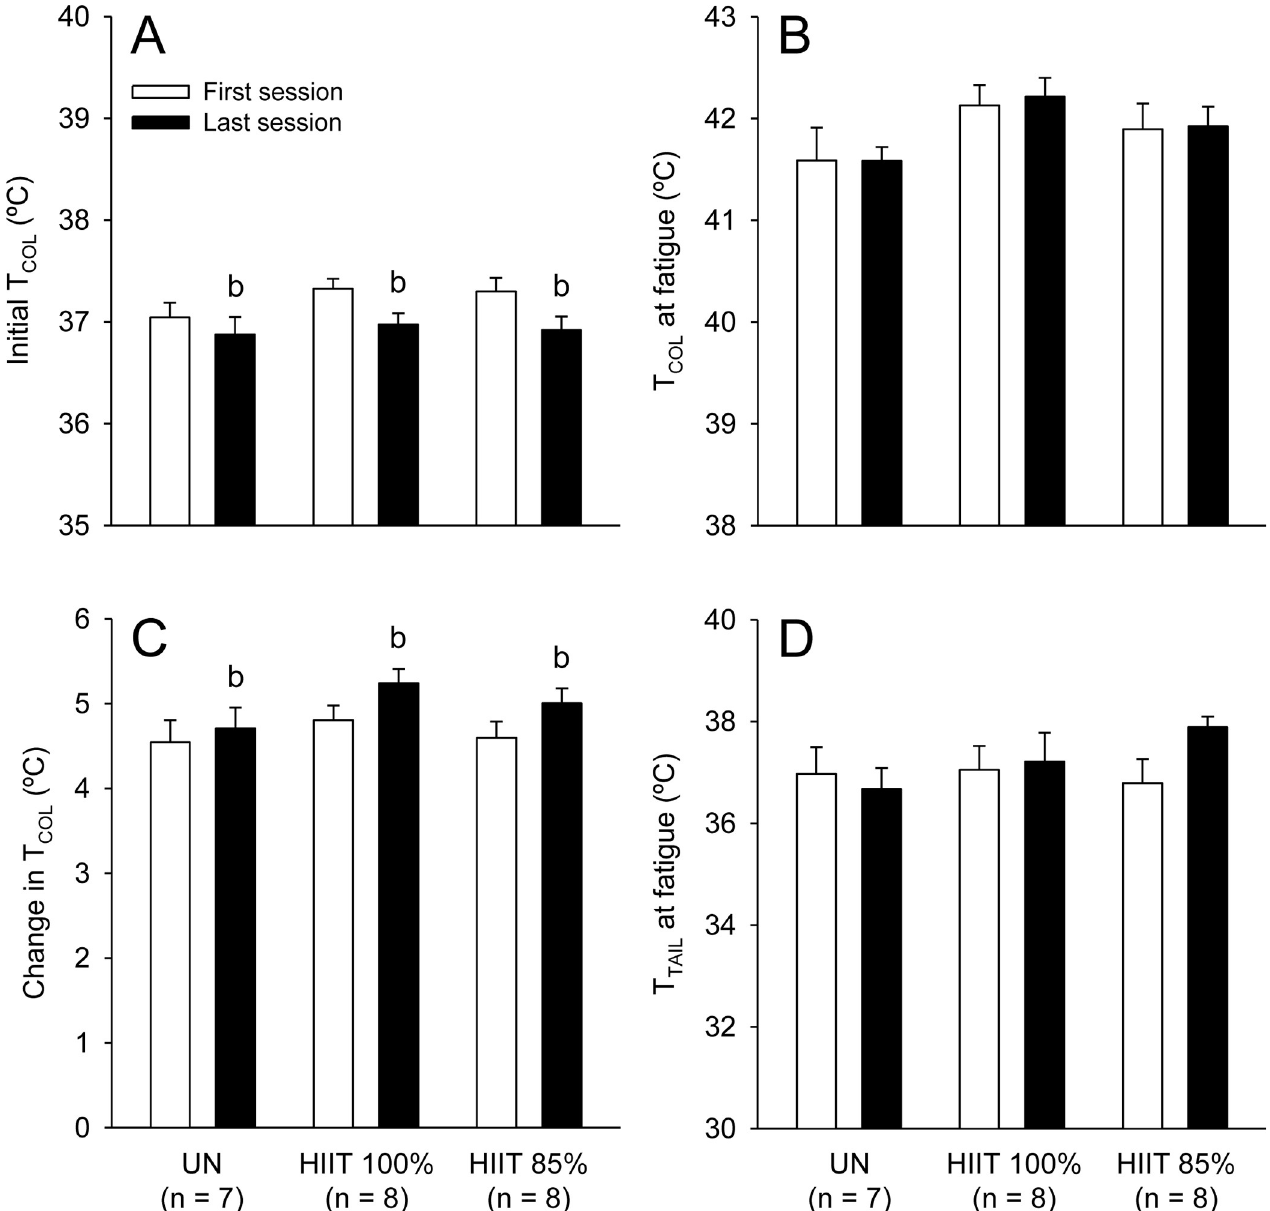
Fig 7. Initial colonic temperature (T COL ; panel A), T COL at fatigue (panel B), change in T COL (panel C) and tail-skin (T TAIL ) temperature at fatigue (panel D) in rats of the three experimental groups in the incremental exercises at pre- and post-interventions. The values are expressed as the means ± SEM. HIIT 100% : high- intensity interval training at 100% of maximal speed; HIIT 85% : high-intensity interval training at 85% of maximal speed; UN: untrained, passive heat exposure. The letter b denotes a main effect of moment (i.e., significantly different from the first session, irrespective of the group; p < 0.05).